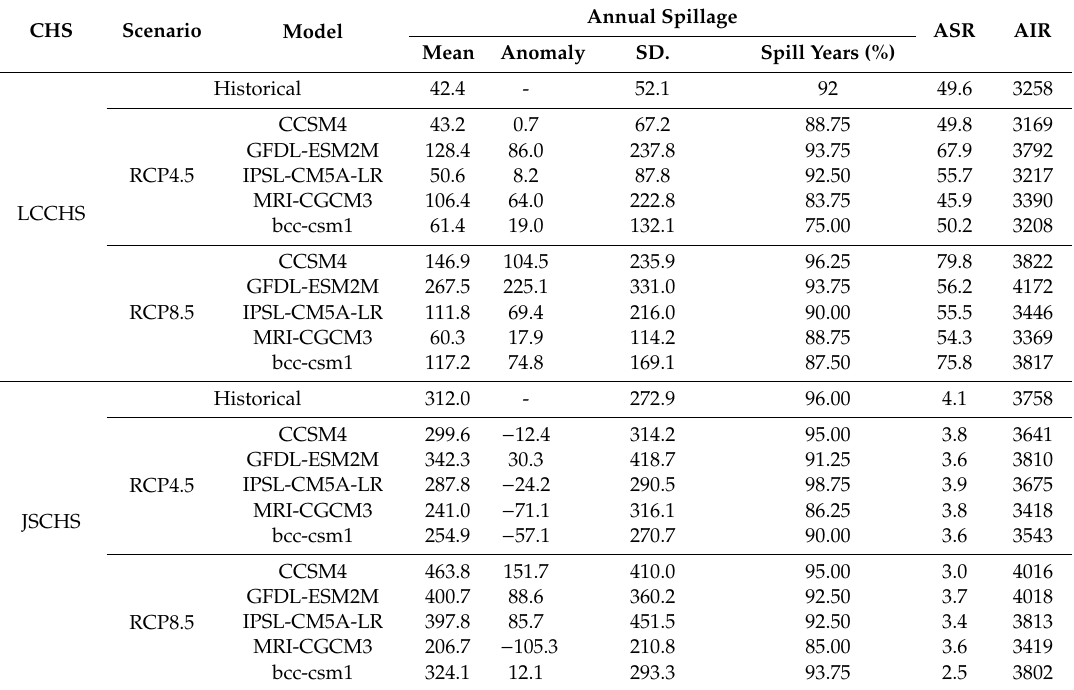
Table 6. The annual spill statistics under each climate change projection (unit, spill: 10 8 m 3 , inflow: m 3 /